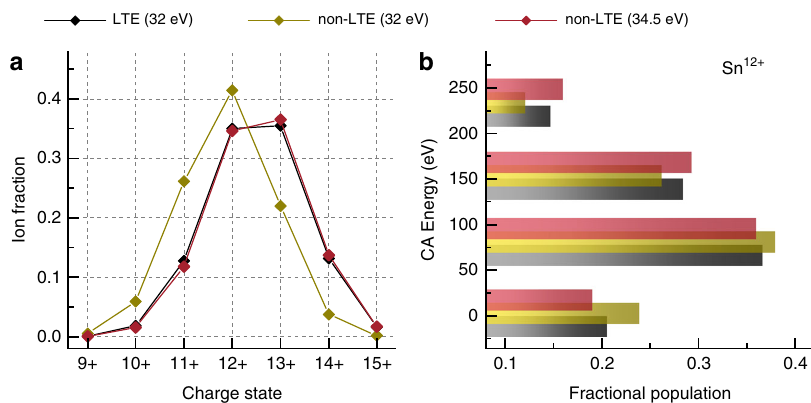
Fig. 5 Validity of local thermodynamic equilibrium (LTE). a Charge state distribution calculations for a 32 eV, 0.002 g cm − 3 (~1 × 10 20 e − cm − 3 ) plasma under both LTE and non-LTE conditions; a non-LTE calculation for a 34.5 eV temperature is additionally shown. b Fractional population in con fi gurations grouped by excitation degree (as in Fig. 2) under conditions indicated in a from con fi guration-averaged (CA) calculations (see main text). CA energies are offset for better